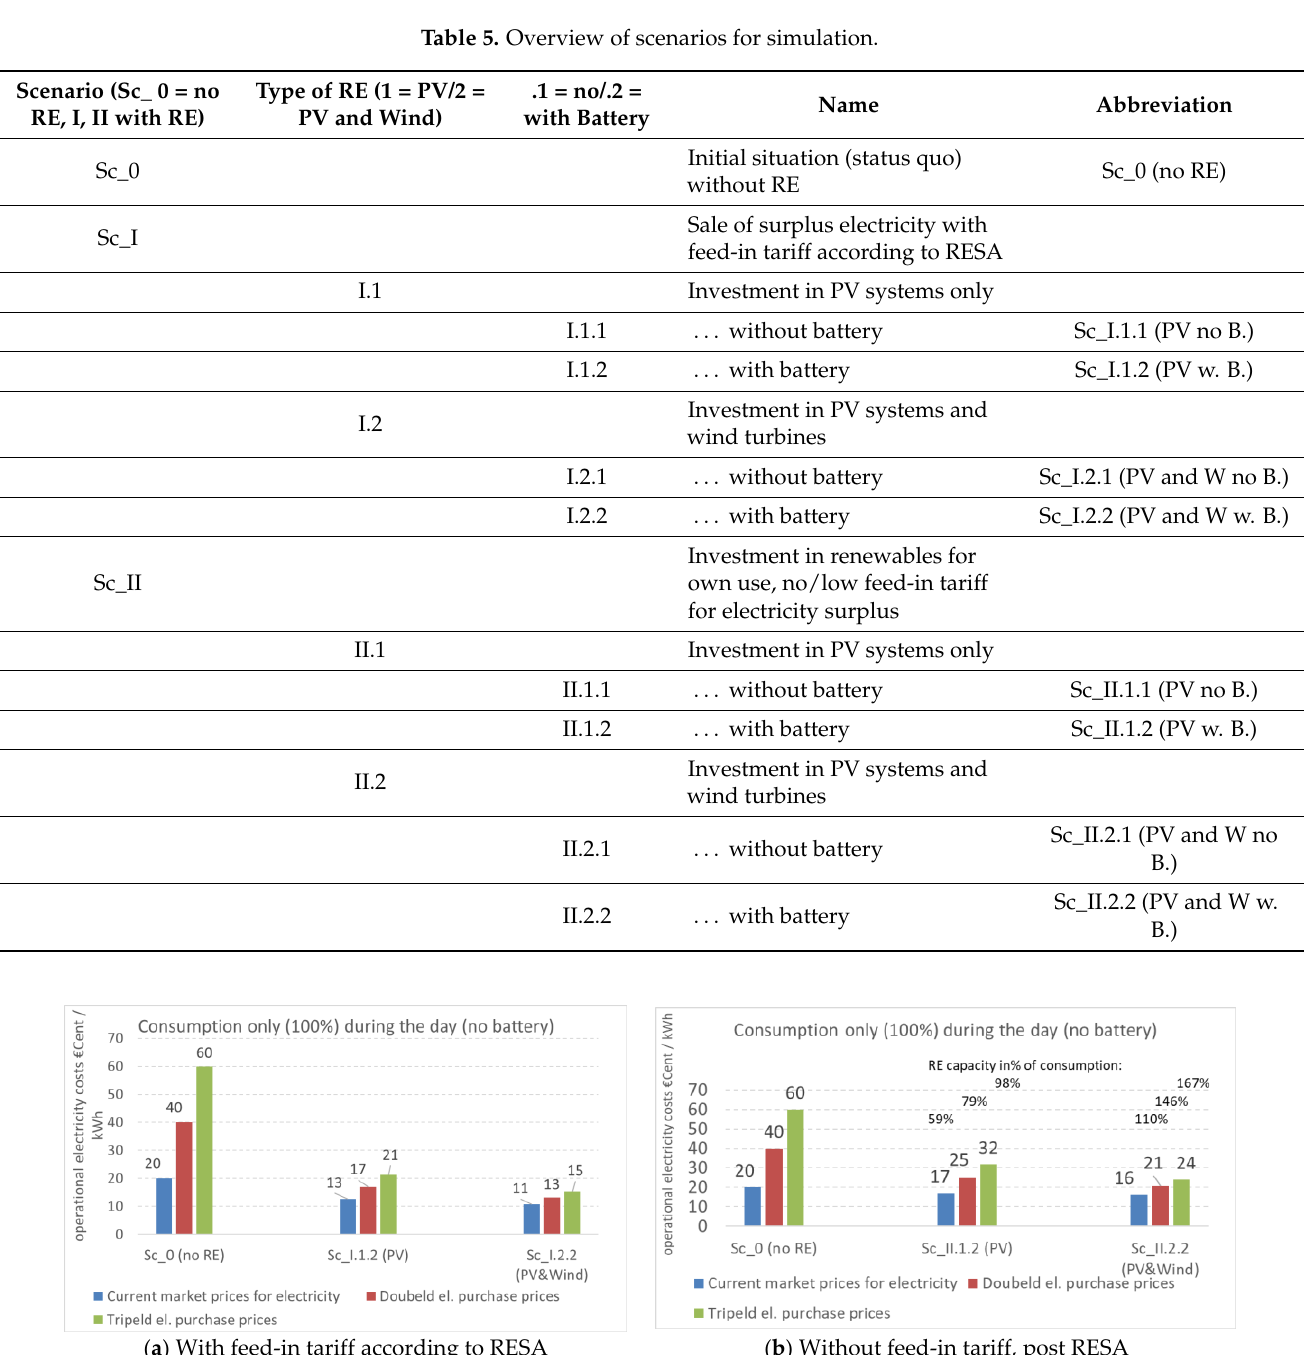
Figure 9. Costs of electricity consumption for an operation with consumption only at night (0% day) for status quo (0.20 ct/kWh) and when electricity price is doubled or tripled and when investing in PV or PV and wind; only when prices triple, with PV power and 100% battery coverage, and with wind and PV and 22% battery coverage (within RESA, a ) or 19% battery coverage (post RESA, b ).